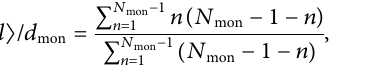
Frontiers in Molecular Biosciences |